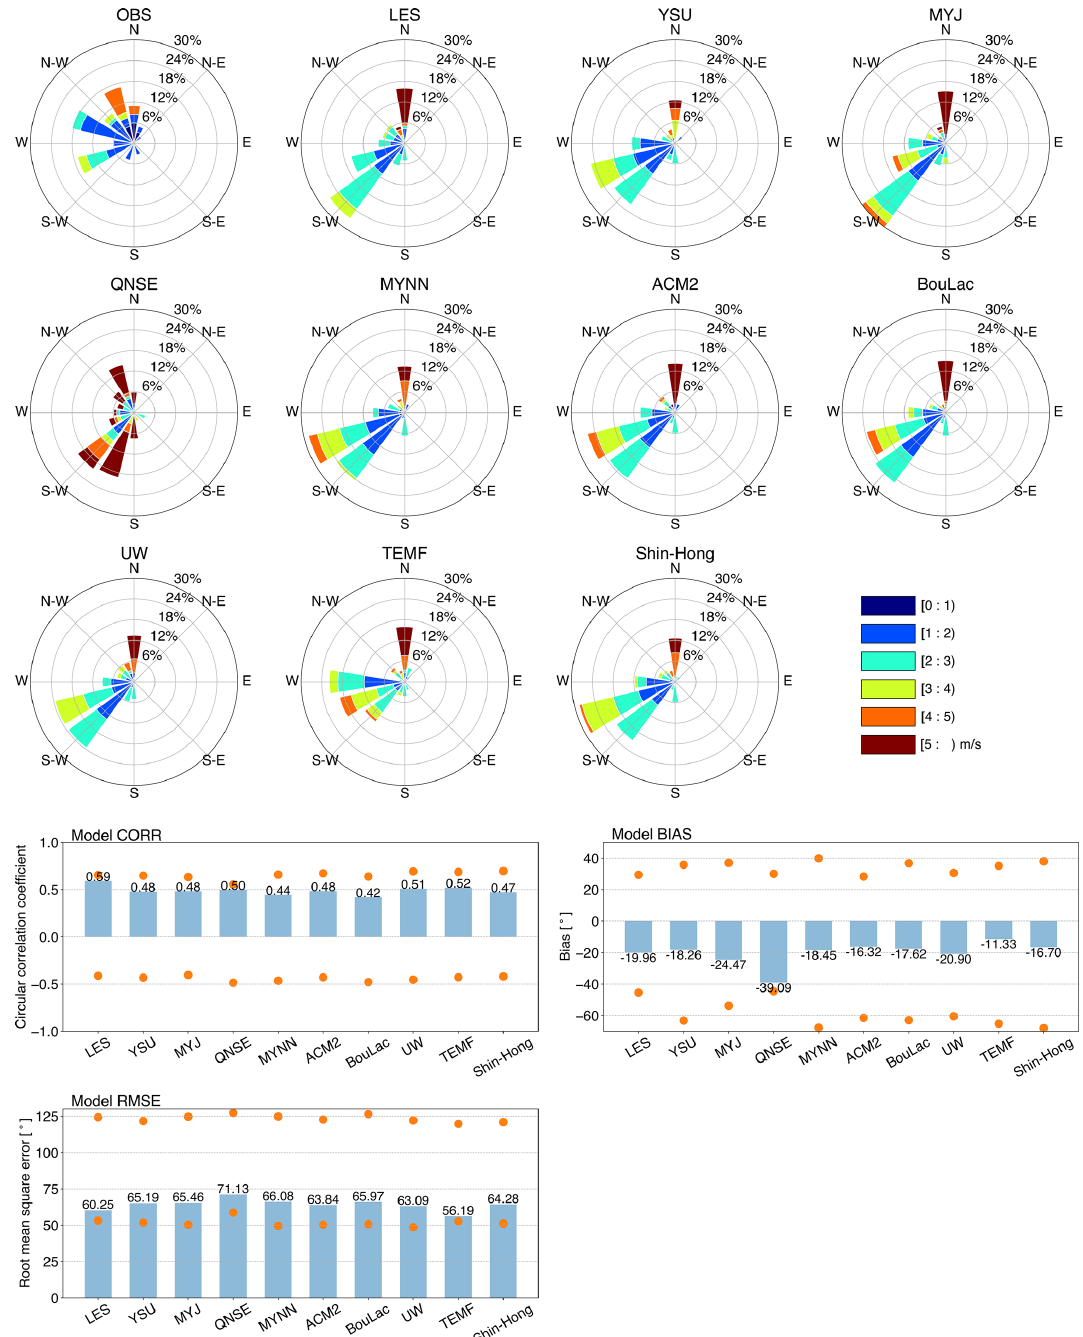
Figure 4. The wind rose charts for the PBL schemes during 11–15 January 2019 averaged over the stations and the corresponding scores of CORR, BIAS, and RMSE; for each wind rose chart, the circles represent the relative frequency (%), and the colors represent wind speed (ms − 1